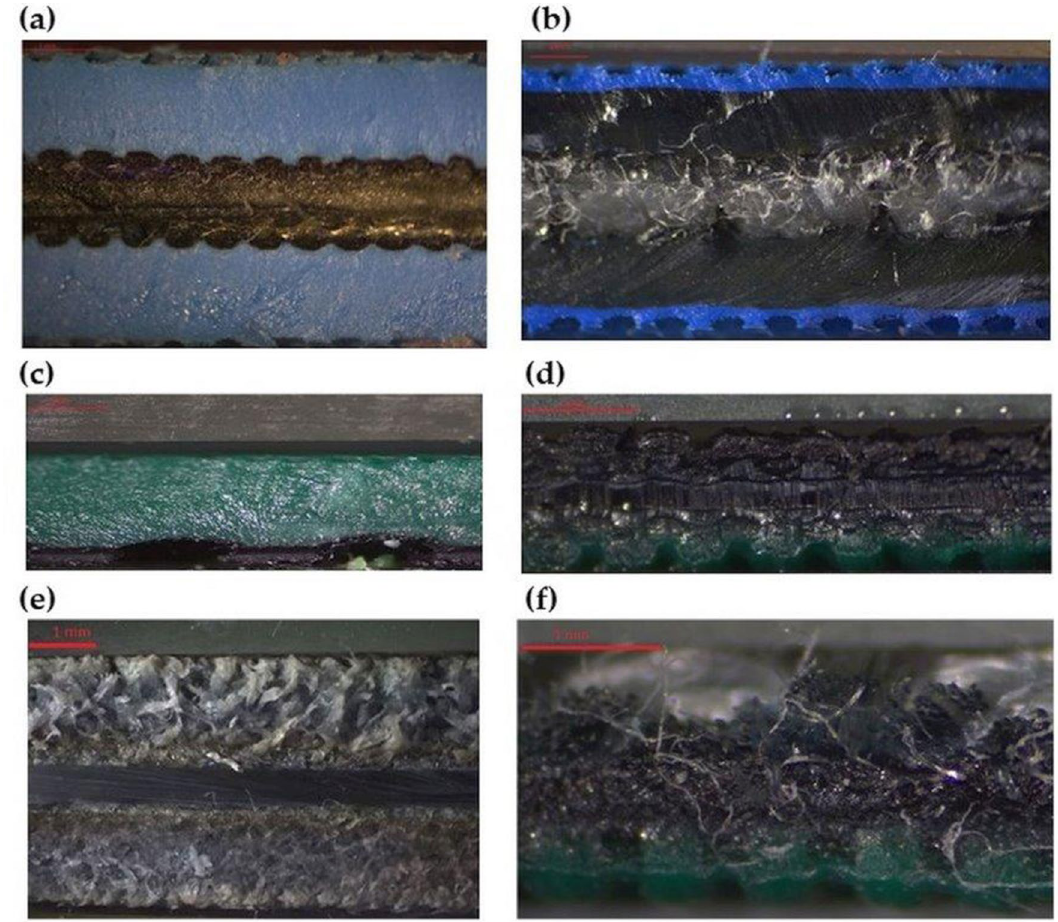
Figure 1. Optical light microscopy images of the internal structure of the flat belts: ( a ) XH, ( b ) TLA, ( c ) TC, ( d ) SG, ( e ) LL2, and ( f )